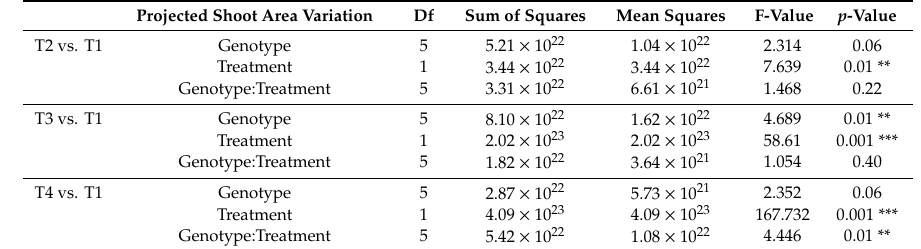
Table 2. Two-way ANOVA table on the e ff ects of genotype and salt treatment level on projected shoot area.